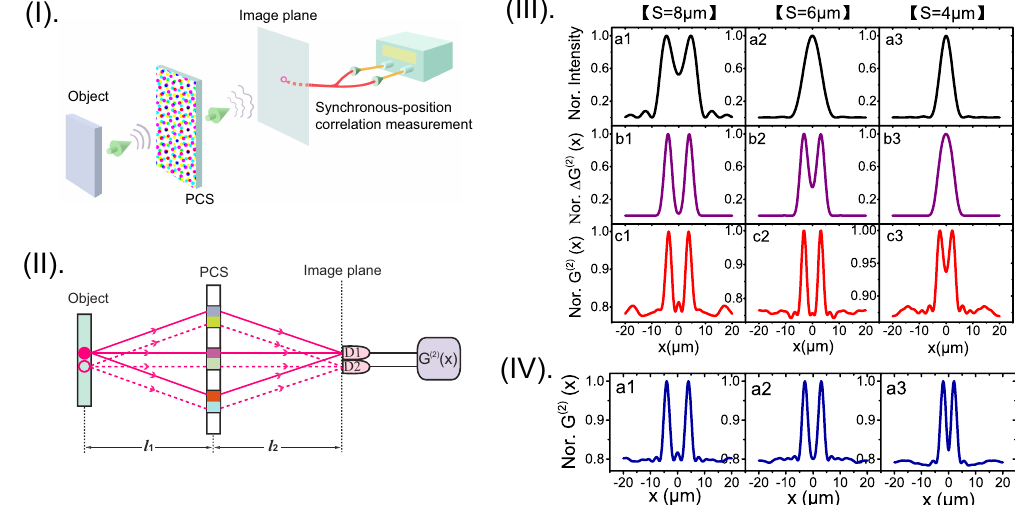
Figure 10. ( I ): Schematic of the super-resolution imaging scheme with a phase-controlled screen (PCS). ( II ): Different but indistinguishable two-photon paths responsible for the super-resolution effect; ( III ): Coherent Heisenberg-resolution imaging with entangled two-photon illumination for double-slit objects of different separation S ( c1 – c3 ). The HL super-resolution effect is demonstrated by comparing with the conventional intensity imaging ( a1 – a3 ) and the SQL super-resolution imaging with thermal/pseudothermal light illumination ( b1 – b3 ). ( IV ): Incoherent Heisenberg-resolution imaging with scanning focused-beam illumination for double-slit objects of different separation S . The figure is reproduced with permissions from Ref. [42] of OSA.